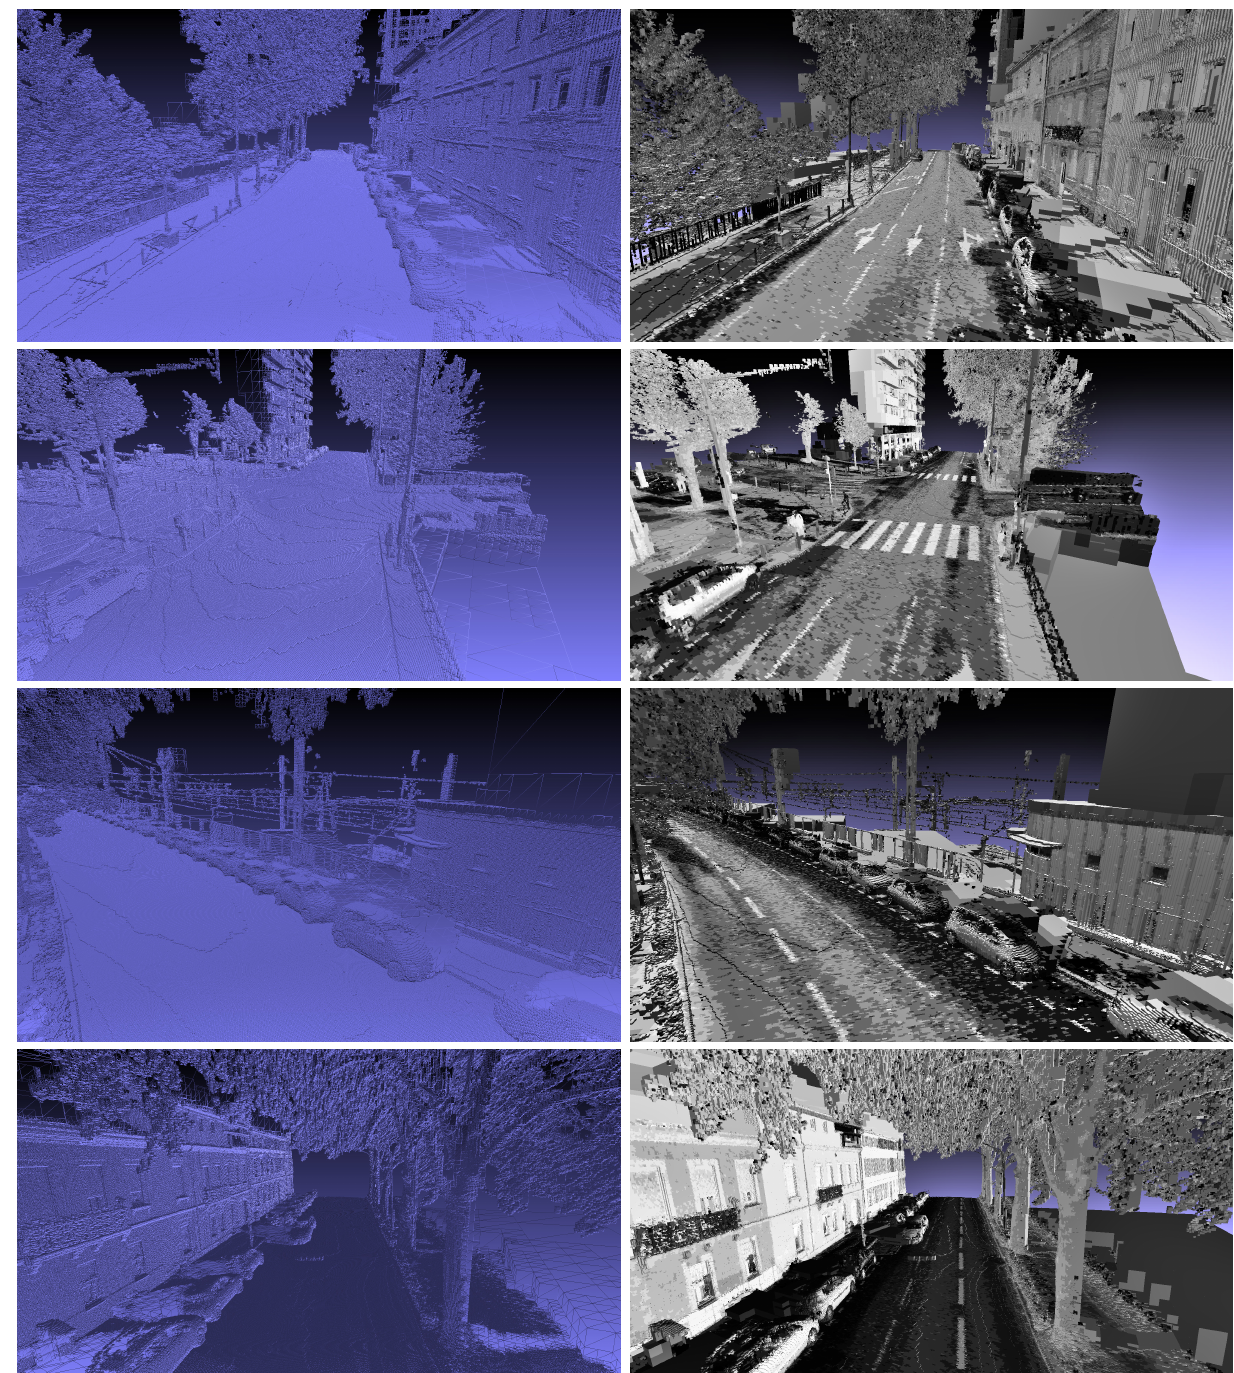
Figure 5: Result of the proposed method. Left column : the resulting mesh. Right column : the mesh textured with the regularized reflectance of the